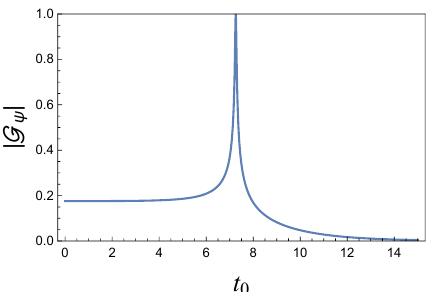
Figure 15. The magnitude of the twisted correlation function as a function of t 0 . Here the parameter is chosen to be β =100 , θ = 10 − 4 and q = 8 . The magnitude is close to one at a time t 0 that is related to the parameter θ